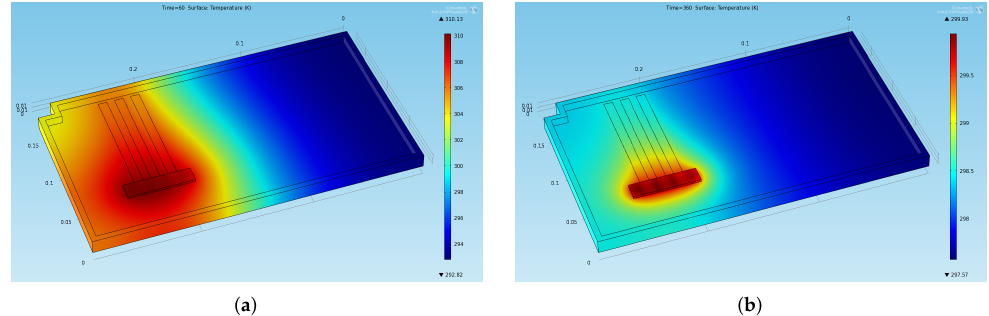
Figure 6. Temperature distribution obtained through the preliminary CFD simulation at two signifi- cant instants of time in the first cycles ( a ) End of the first thermal charge phase: t = 60 s. ( b ) Beginning of the second thermal charge phase: t = 360 s.